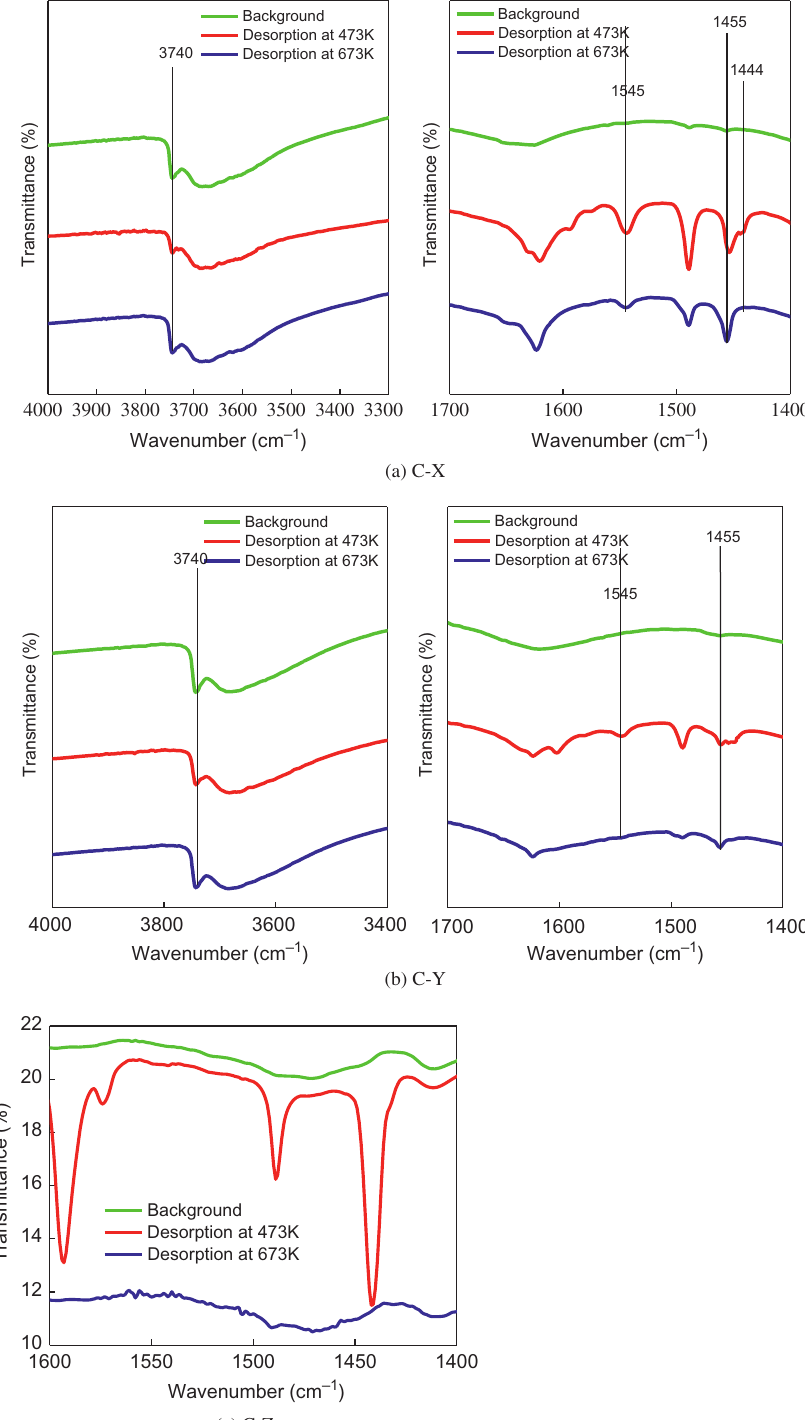
Figure 2: Py-FTIR spectra of pyridine desorbed on C-X, C-Y, and